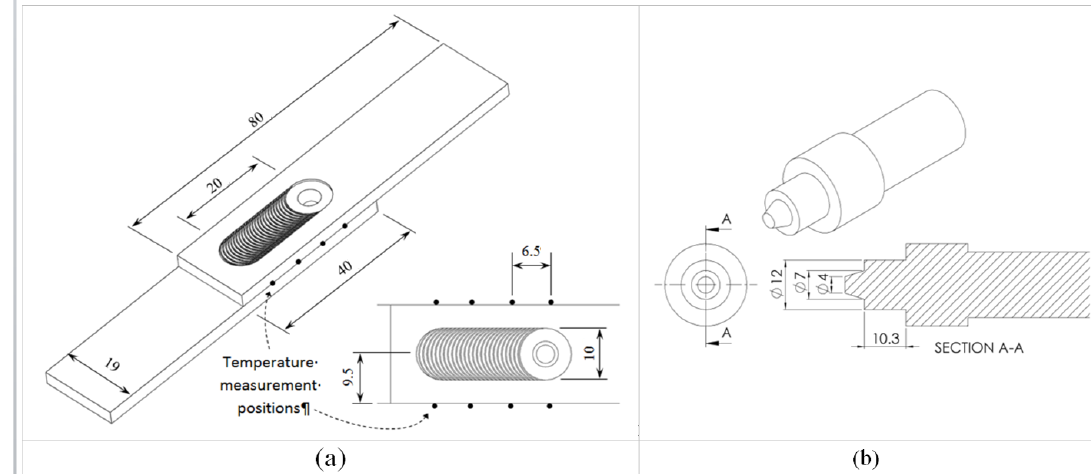
Figure 1. Welded samples (a) and tool geometry and dimensions (b). Table 2. Process Parameters Welding Design WD